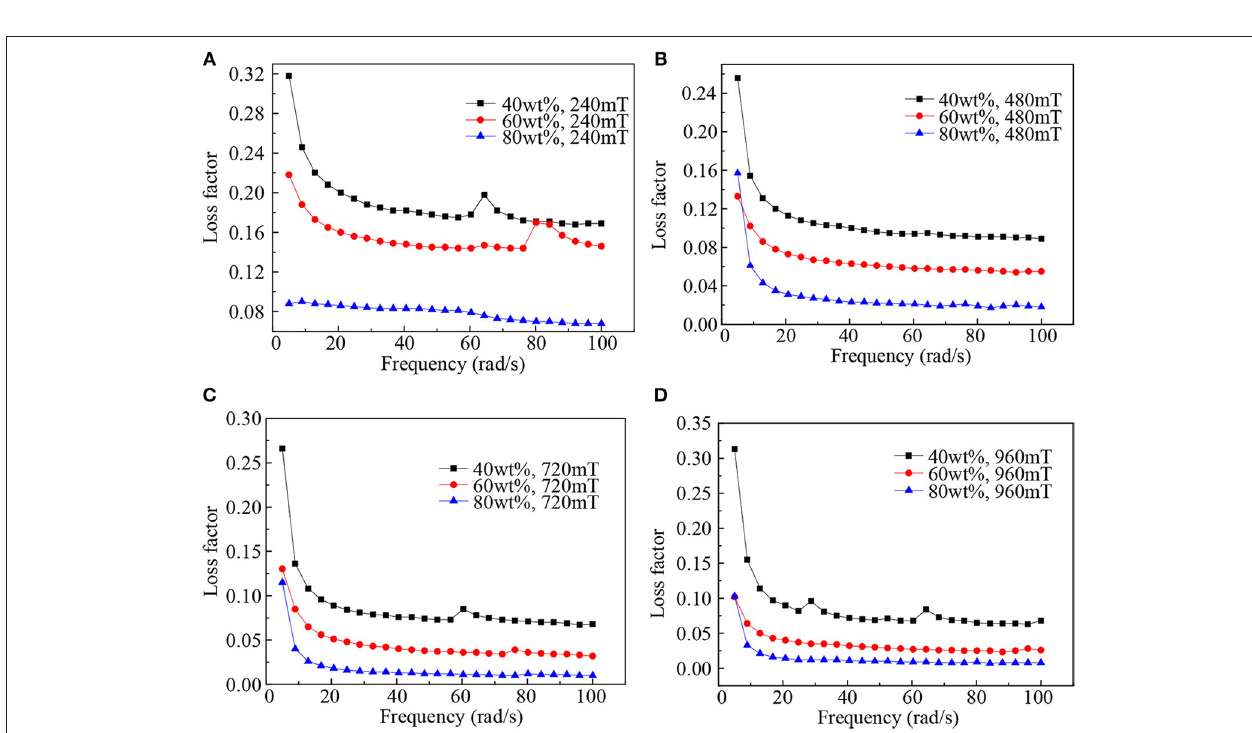
FIGURE 10 | Loss factor as a function of angular frequency. ( A : B = 240mT; B : B = 480mT; C : B = 720mT; D : B = 960mT).